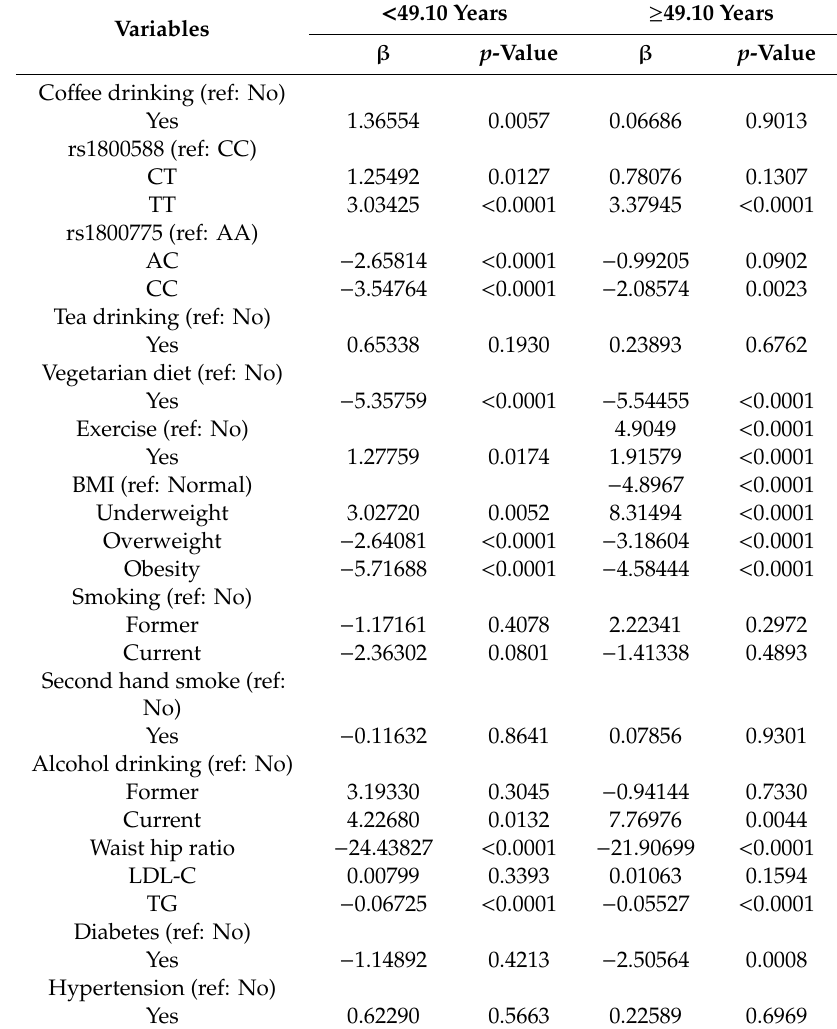
Table 4. Linear regression showing the association between co ff ee drinking and HDL-C in women stratified by menopausal